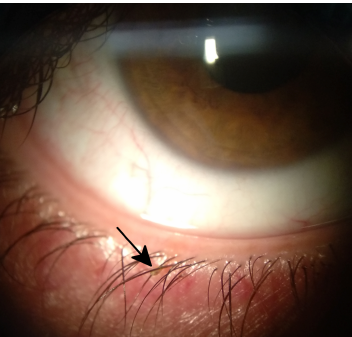
Figure 2: Slit-lamp photography; an egg with a nit inside is